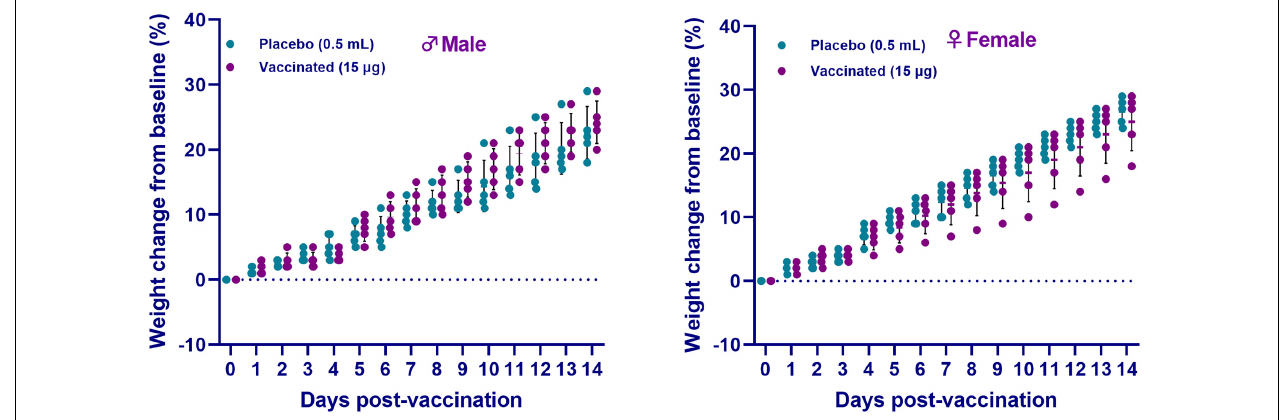
FIGURE 3 | The changes in the live weight of hamsters after administration of the QazCovid-in vaccine candidate. The vaccinated groups were compared to the placebo group (PBS). Data are presented as mean ± standard deviation (SD). The statistical significance was assessed using two tailed ANOVA between the two groups with a Šídák’s multiple comparisons test; p < 0.05 was considered statistically